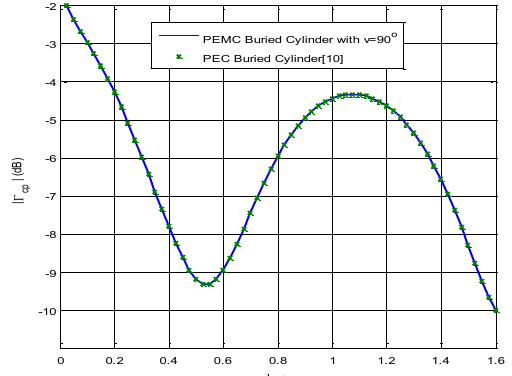
Fig. 2. Variation of the magnitude of co-polarized reflection coefficient versus k circular cylinders of radius a , with v =90 o , and d =2.25 cm.